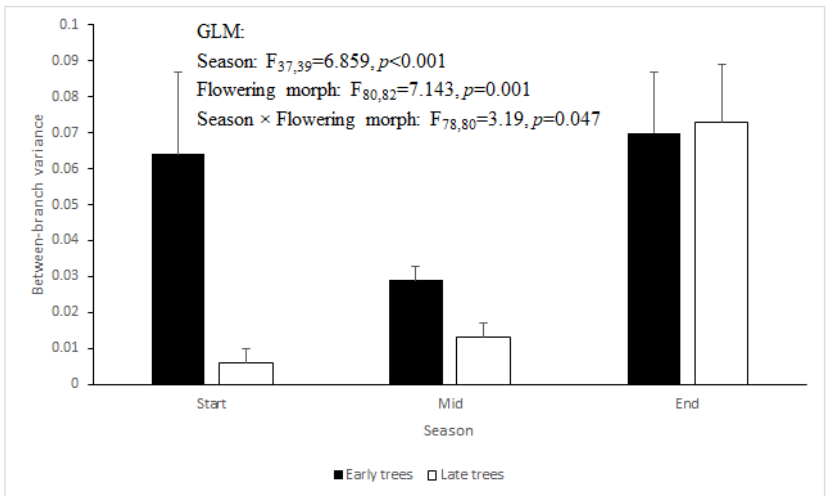
Figure 2. Among-branch variance of the proportion of male-phase flowers in the ‘Early’ and ‘Late’ flowering morphs along the flowering season. Means ± SE of the per-tree variances are plotted.